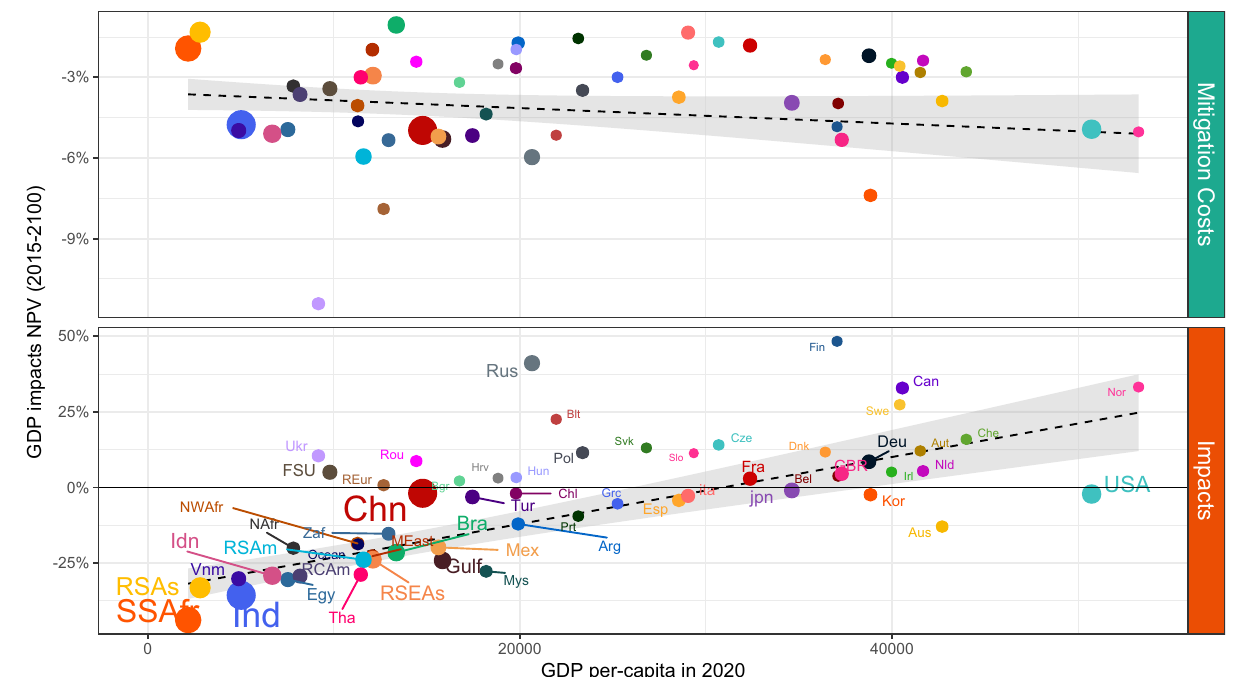
Fig. 3 GDP net-present-value impacts and costs against current GDP per-capita. NPV is evaluated for interval 2015 – 2100, with world-average Ramsey yearly discount rate. Reported scenario is cooperative, SSP2, under BHM-SR impact function and intermediate levels for inequality aversion ( γ = 0.5) and utility discount rate ( ρ =